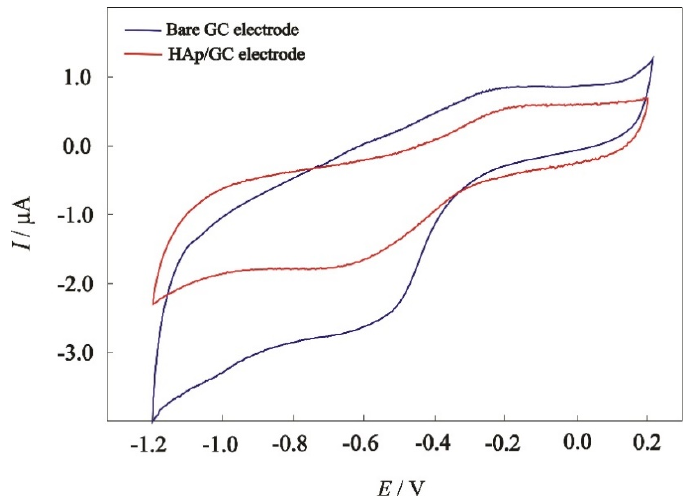
Figure 5. Cyclic voltammograms obtained on a bare GC electrode and a HAp/GC electrode in 0.2 M KNO 3 (pH = 4) with a scan rate of 25 mV/s, going from 0.0 V to the cathodic direction. These measurements were carried out without oxygen removed from the solution.